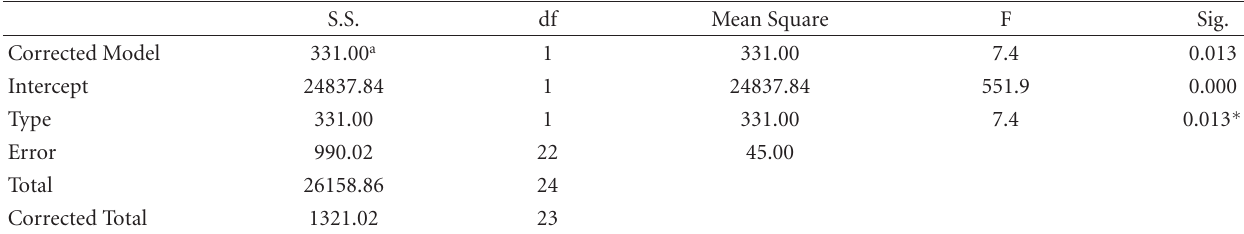
Table 2: The results of a univariate ANOVA showing the significant e ff ect of predominant symbiont type (C2 or D) on the chlorophyll a content of Acropora millepora colonies in winter (July 2005) before a bleaching. The corrected model shows the variation in the dependent variable by other e ff ects (other than the intercept) after correction for the mean. ∗ indicate significant results. S.S.